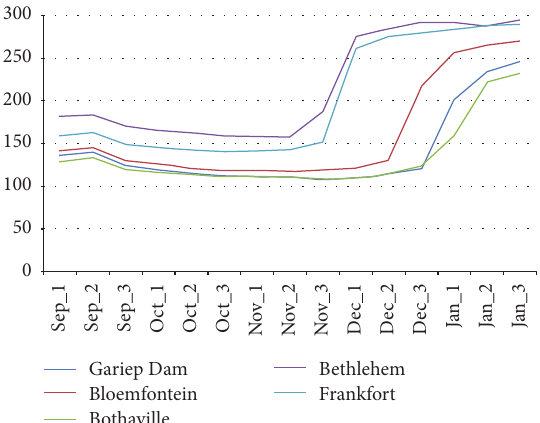
Figure 5: Length of growing period in days for a medium season maize variety for the Gariep Dam, Bloemfontein, Bothaville, Bethlehem, and Frankfort stations from the 1st dekad of September to 3rd dekad of